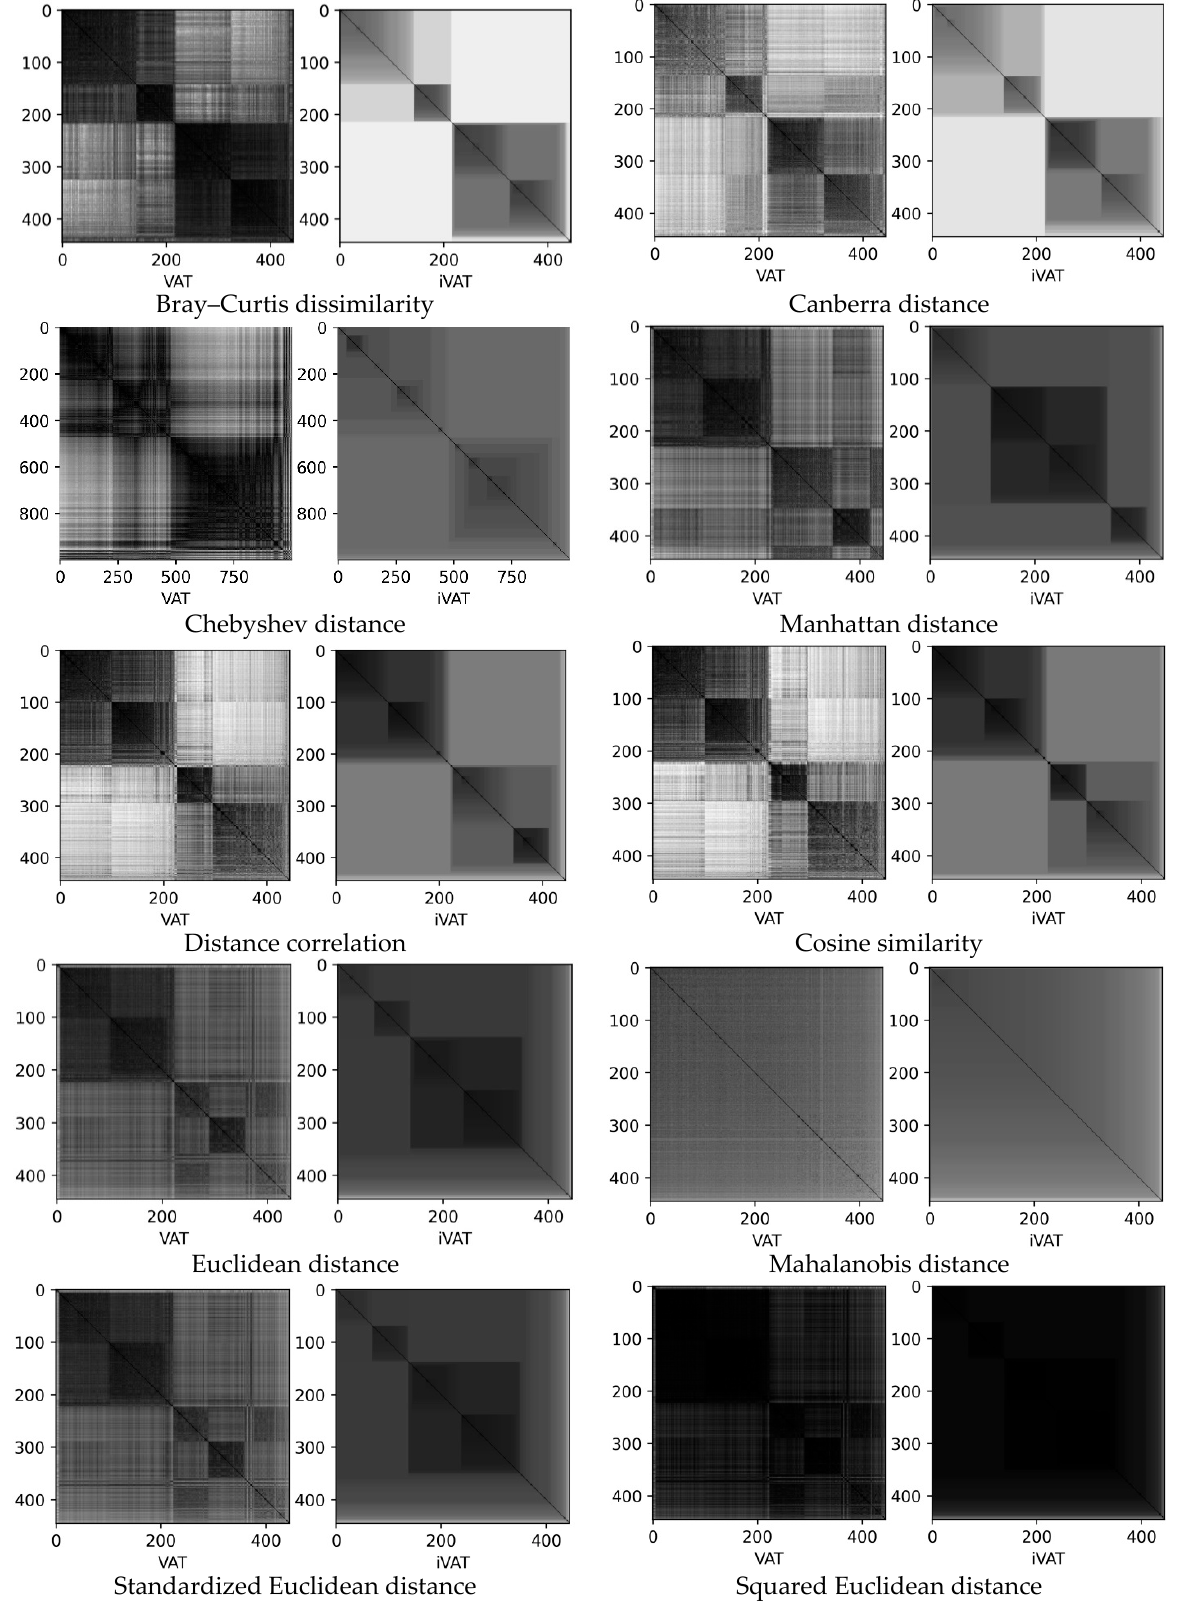
Figure A5. Microchips 1526IE10_002, four-batch mixed lot. Cluster heat map.